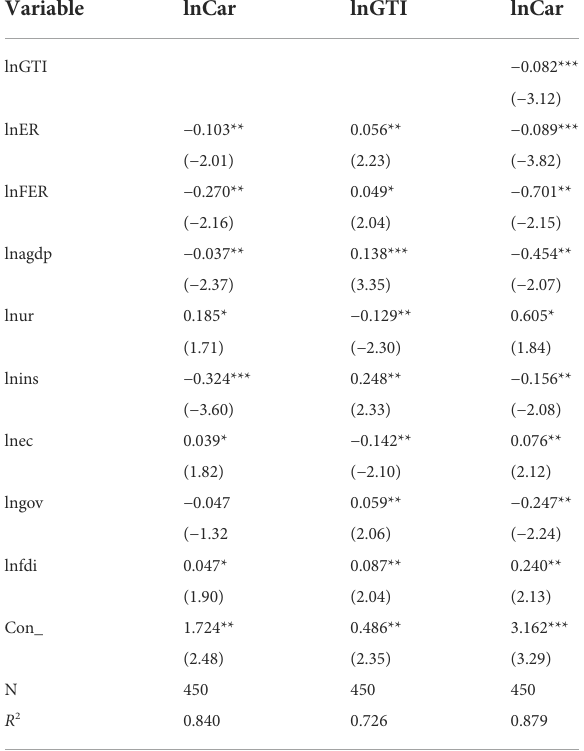
TABLE 3 Robust test